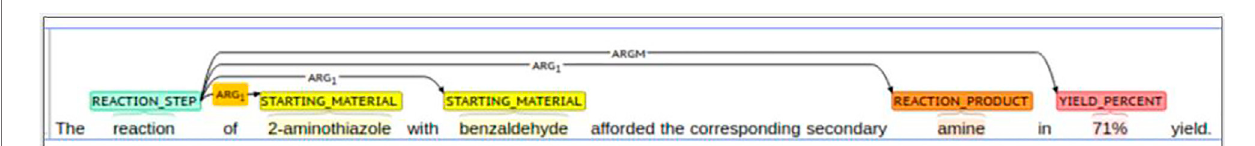
FIGURE 1 | An example from the CLEF ChEMU-2020 dataset that shows the entities, trigger words, and events.